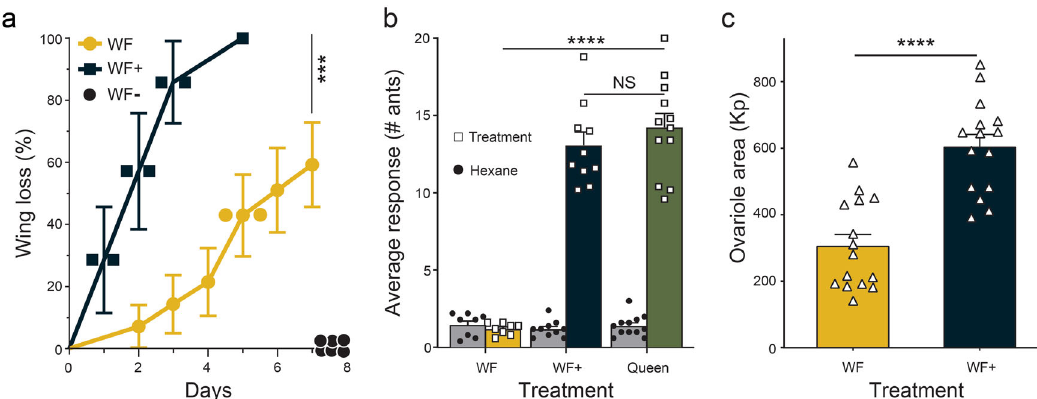
Fig. 4 Phenotypic effects of tyramine injection into winged females. a Tyramine (aqueous solution) injected into winged females (WF + , n = 7) leads to quicker dealation than for winged females injected with water (WF, n = 14). Eight winged females injected with water lost their wings by day 7 (yellow circles); however, six winged females injected with water did not dealate within the 7-day experiment (WF − , black circles on x- axis). Data analyzed by Log- rank, Mantel − Cox test). b Bar on left of each of the three pairs of bars is the worker response to the hexane control. Venom sac extracts from tyramine injected winged females (WF + , n = 10) resulted in 1) a signi fi cantly higher number of responding worker ants than for venom sac extracts from saline injected winged females (n = 8), and 2) the number of responding worker fi re ants was not different from worker response to mature queen poison sac extract ( n = 12) 24 . Comparisons made with Brown − Forsythe ANOVA (with Dunnett ’ s T3 MCT post hoc). c Tyramine injected into winged females ( n = 15) led to signi fi cantly larger ovarioles compared to ovarioles from water-injected winged females ( n = 15, comparison made with t-test). All n values represent biologically independent samples. Bars represent mean ± SEM, *** p < 0.001; **** p < 0.0001, NS not signi fi